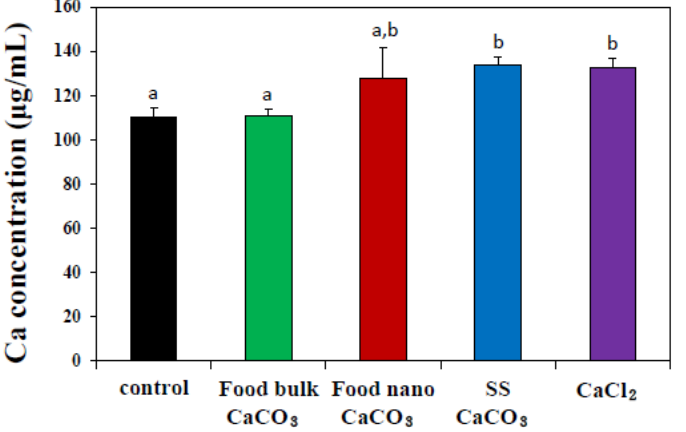
Figure 6. Intestinal transport of three different types of CaCO 3 particles or an equivalent amount of CaCl 2 (based on calcium content) by microfold (M) cells using an in vitro model of human FAE after 6 h of incubation, as measured by inductively coupled plasma-atomic emission spectroscopy (ICP-AES). The mean values with different letters (a, a,b, b) in tested groups indicate statistically significant difference ( p <